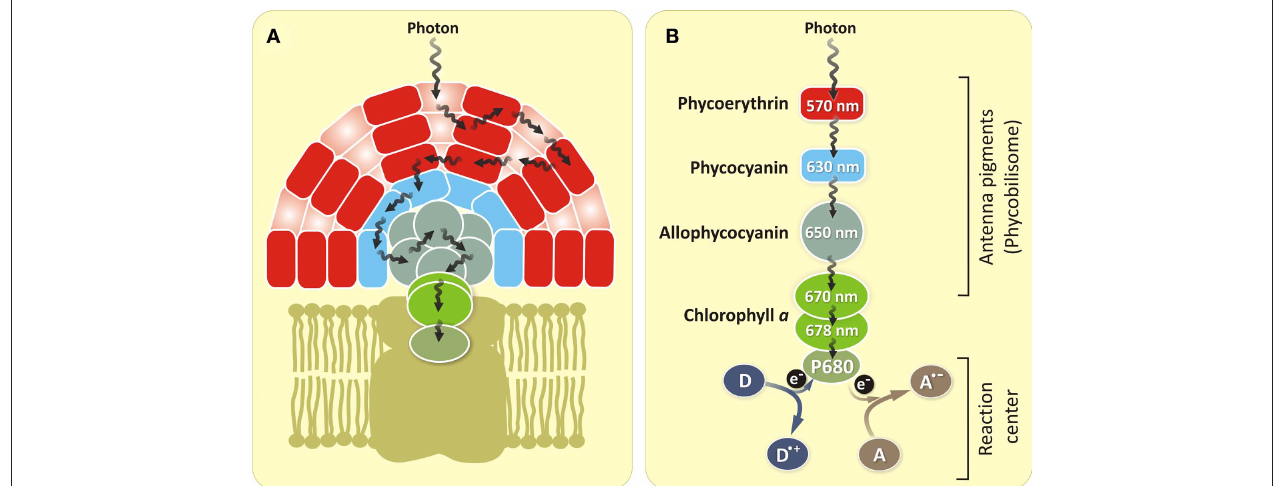
FIgurE 2 | Structural organization of the antenna system of PSII for red algae and cyanobacteria (A) and energy transfer steps including charge separation (photochemical reaction) at the PSII rC (B) for cyanobacteria. The energy of absorbed photons is passed through a number of antenna molecules [phycoerythrin (absent in most cyanobacteria) → phycocyanin → allophycocyanin]